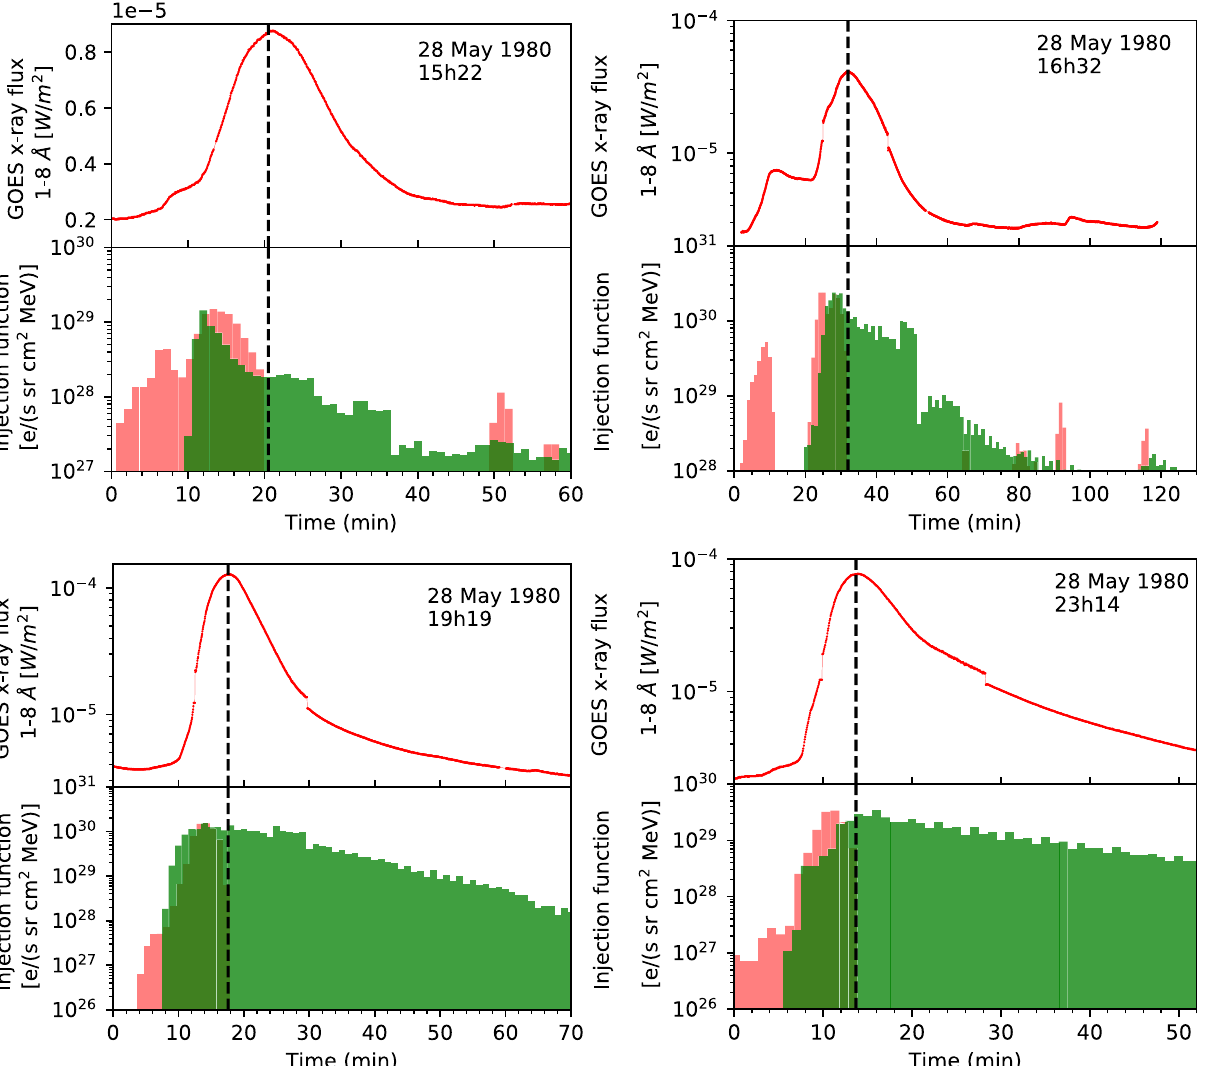
Fig. 2. GOES-3 soft X-ray fl ux (top panels), the time derivative of the soft X-ray fl ux (red bars), and the results of Pacheco et al. (2019) (green bars) of the four consecutive SEP events of 28 May 1980. The time in each plot is solar